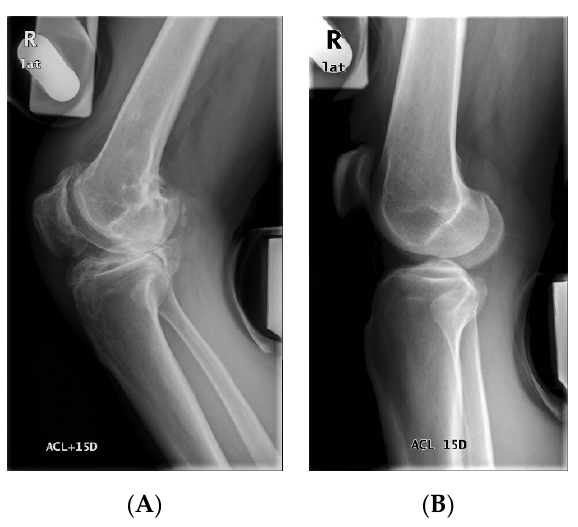
Figure A1. The original images of two unsuccessful cases are shown here. In these cases, the segmentation results of the femoral condyles were inappropriate due to ( A ) severe degenerative changes of the knee joint, and ( B ) the fuzzy margin of the medial femoral condyle on the radiograph.